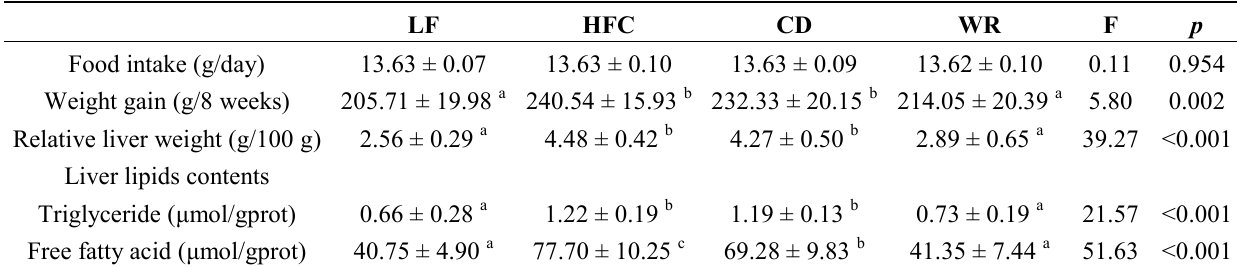
Table 2. Weight gain, relative liver weights and liver lipids, according to four diet groups.